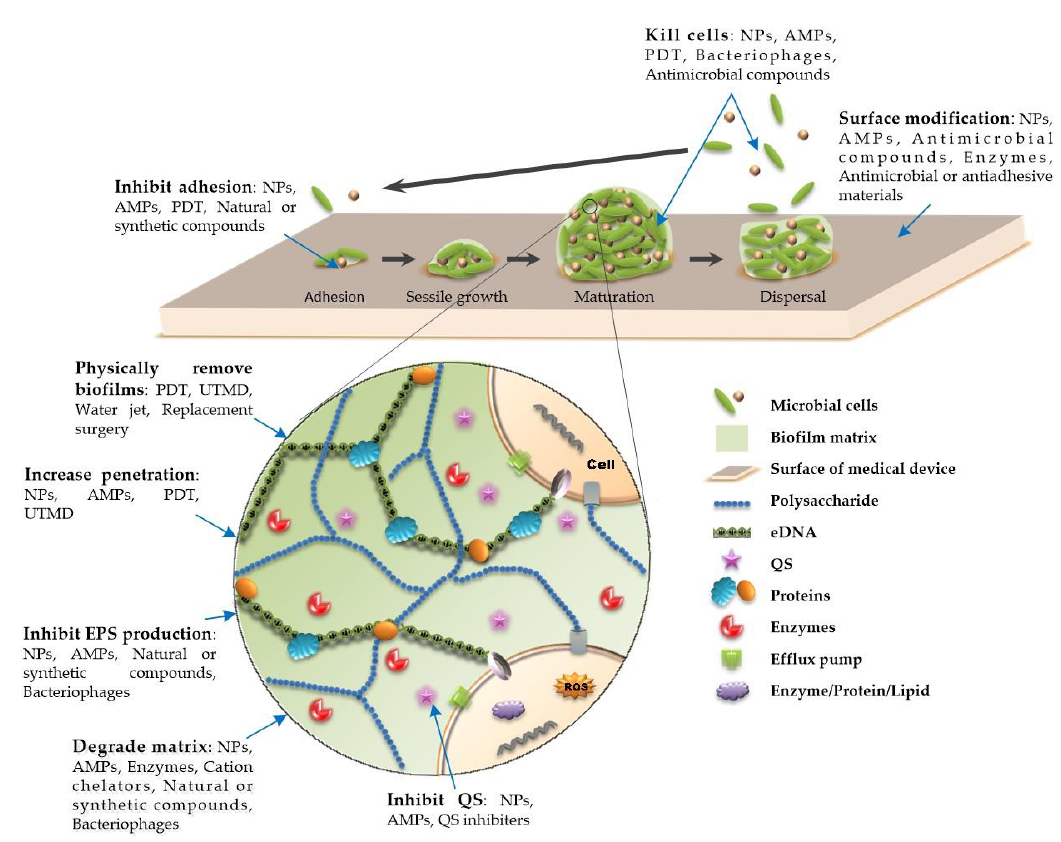
Figure 1. Stages of medical device-associated biofilm formation and approaches against biofilms.